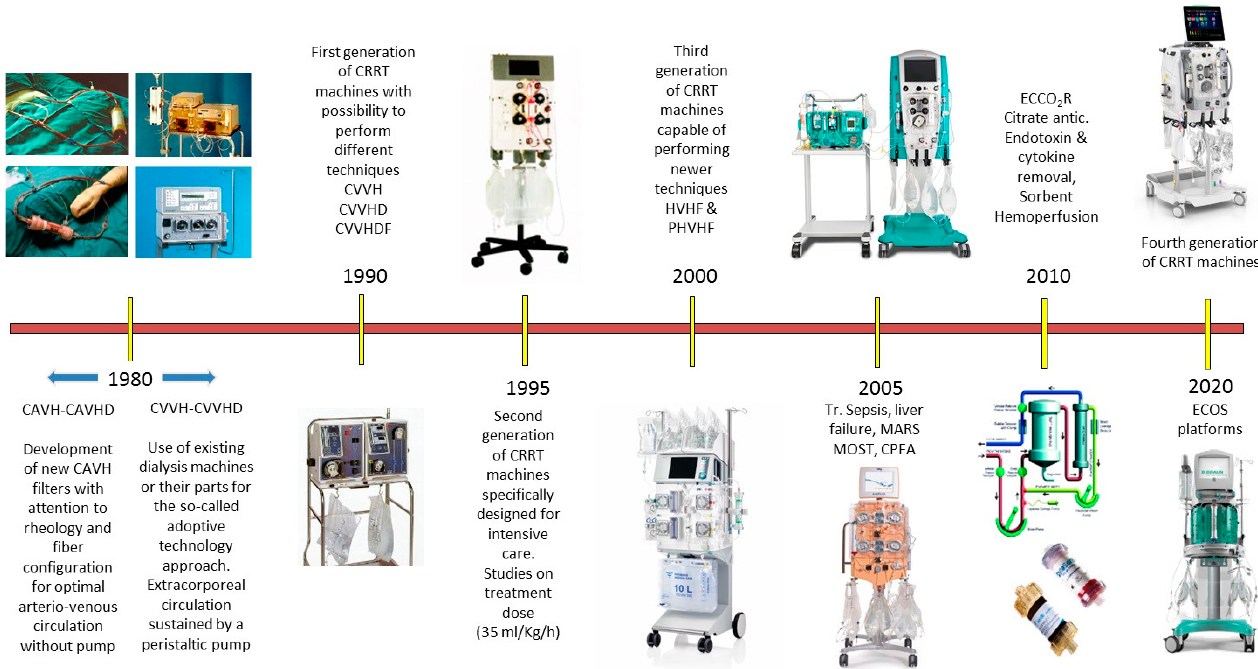
Figure 1. Evolution of continuous renal replacement therapy (CRRT) technology for adult patients (reproduced and modified with permission from Ronco C: Nefrologia Critica, Piccin Nuova Libraria, Padova, 2021). CVVH, continuous veno-venous hemofiltration; CVVHD, continuous veno-venous hemodialysis; CVVHDF, continuous veno-venous hemodiafiltration; HVHF, high-volume hemofiltration; PHVHF, pulse high volume hemofiltration; ECCO 2 R, extracorporeal CO 2 removal; CAVH, continuous arteriovenous hemofiltration; CAVHD, continuous arteriovenous hemodialysis; MARS, molecular adsorbent recirculating system; MOST, multiple organ support therapy; CPFA, coupled plasma filtration adsorption; ECOS, extracorporeal organ support.